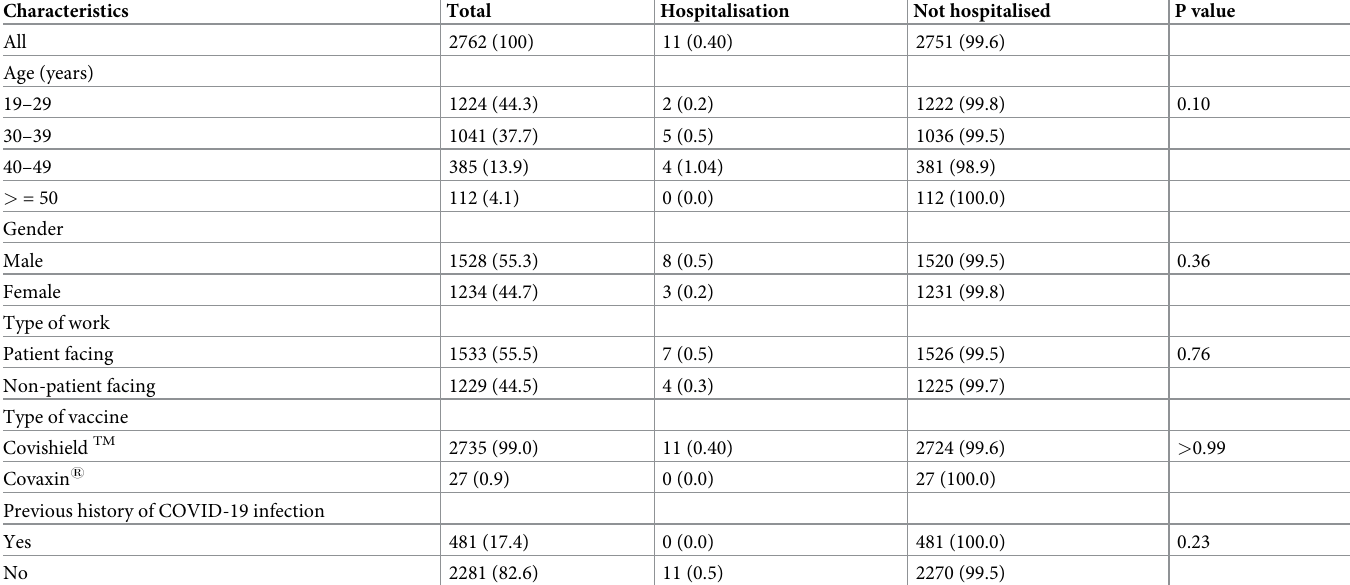
Table 3. Table showing the proportion of hospitalisations due to COVID-19 infection in a cohort of 2762 health care personnel in a tertiary care centre, Mumbai, India.